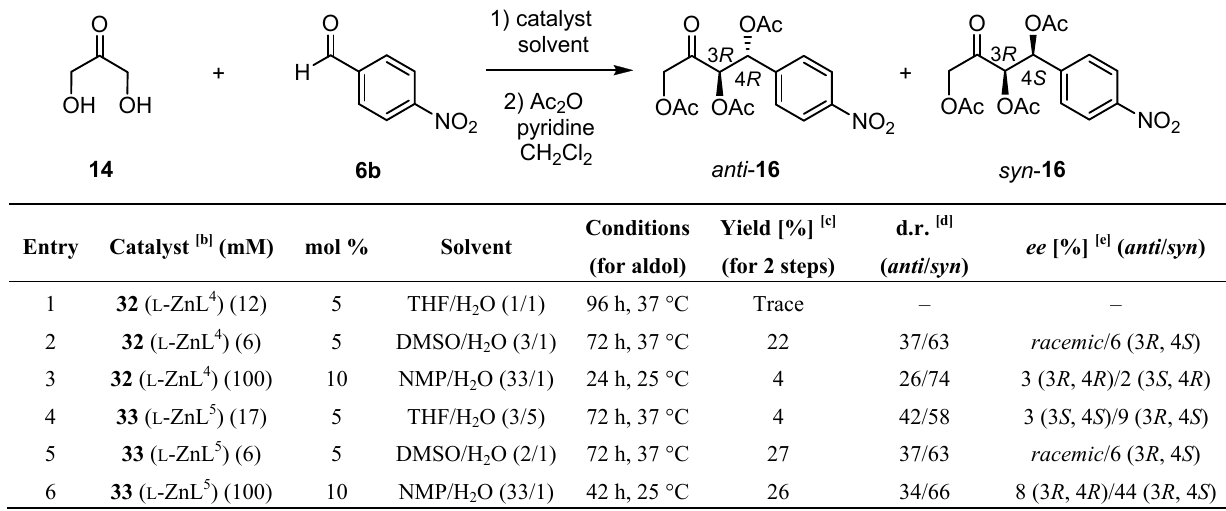
Table 7. Results for an asymmetric aldol reaction between 14 [a] and 6b catalyzed by 32 ( L -ZnL 4 ) and 33 ( L -ZnL 5